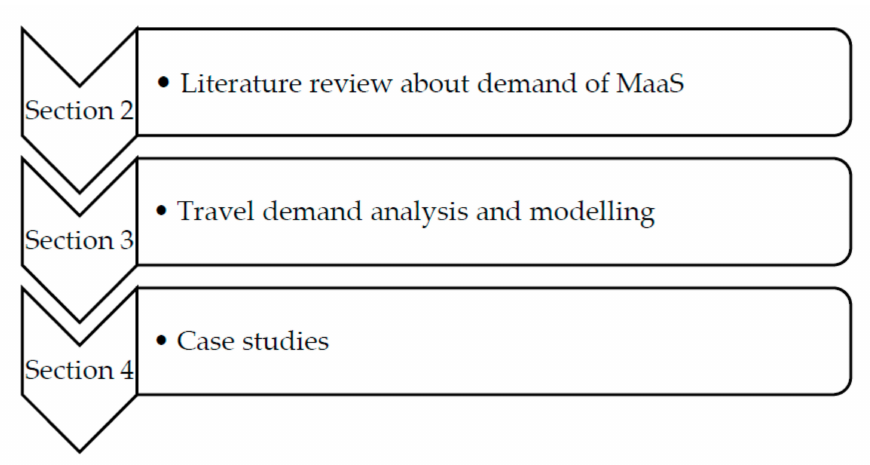
Figure 1. Steps of the research